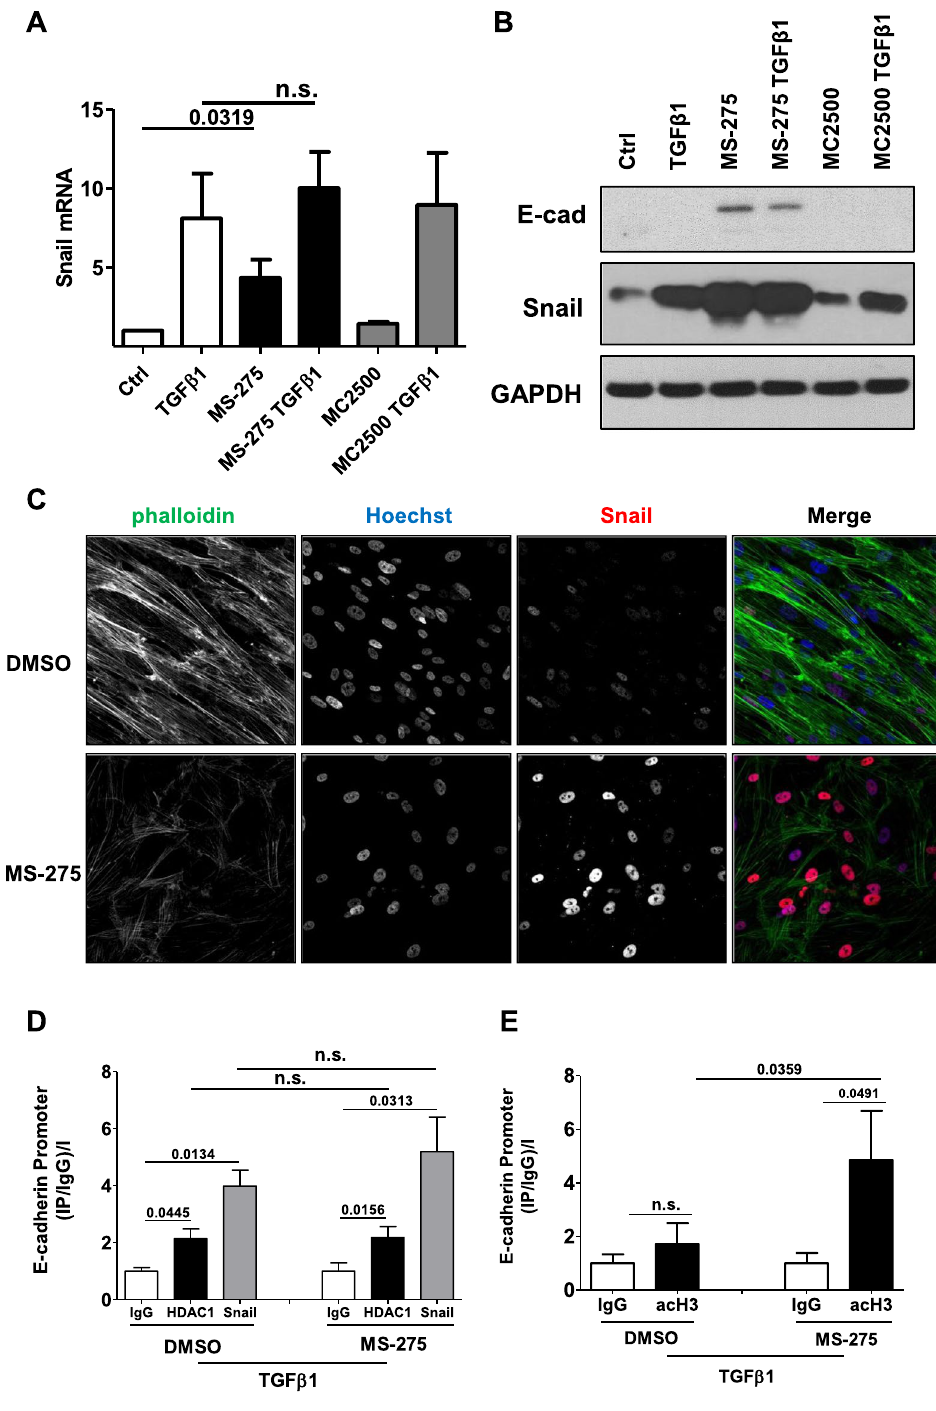
Figure 6. Treatment with MS-275 increases Snail expression while impairing its activity. ( A ) Effect of treatment with HDAC inhibitors over Snail expression in MCs. MCs were treated with DMSO vehicle (NT), with MS-275 (250 nM) or MC-2500 (250 nM) for 72 h. Samples were left untreated or were treated with TGF β 1 (2 ng/ml) for the last 24 h. Expression of Snail was evaluated on total RNA by qRT-PCR. n = 4. ( B ) Representative Western blot experiment of 5 performed showing expression of E-cadherin and Snail from cell lysates of MCs treated as above. GAPDH was used as a loading control. ( C ) Effect of MS-275 treatment on Snail expression and localization. MCs were treated with MS-275 (250 nM), or DMSO for 48 hr and then stimulated with TGF β 1 (2 ng/ml) for 24 h before processing for immunofluorescence with a monoclonal antibody against Snail. Cell nuclei are shown in blue (Hoechst 33342). Confocal images are shown from one representative experiment of three performed. ( D ) qPCR analysis of ChIP assays with anti-Snail (Snail) and anti-HDAC1 (HDAC1) antibodies and, as control, normal rabbit IgG (IgG) on chromatin from MeT5A cells treated with MS-275 for 72 h or with DMSO, and treated with TGF β 1 for 24 h (TGF β 1). Data show the enrichment of Snail and HDAC1 on Snail consensus binding